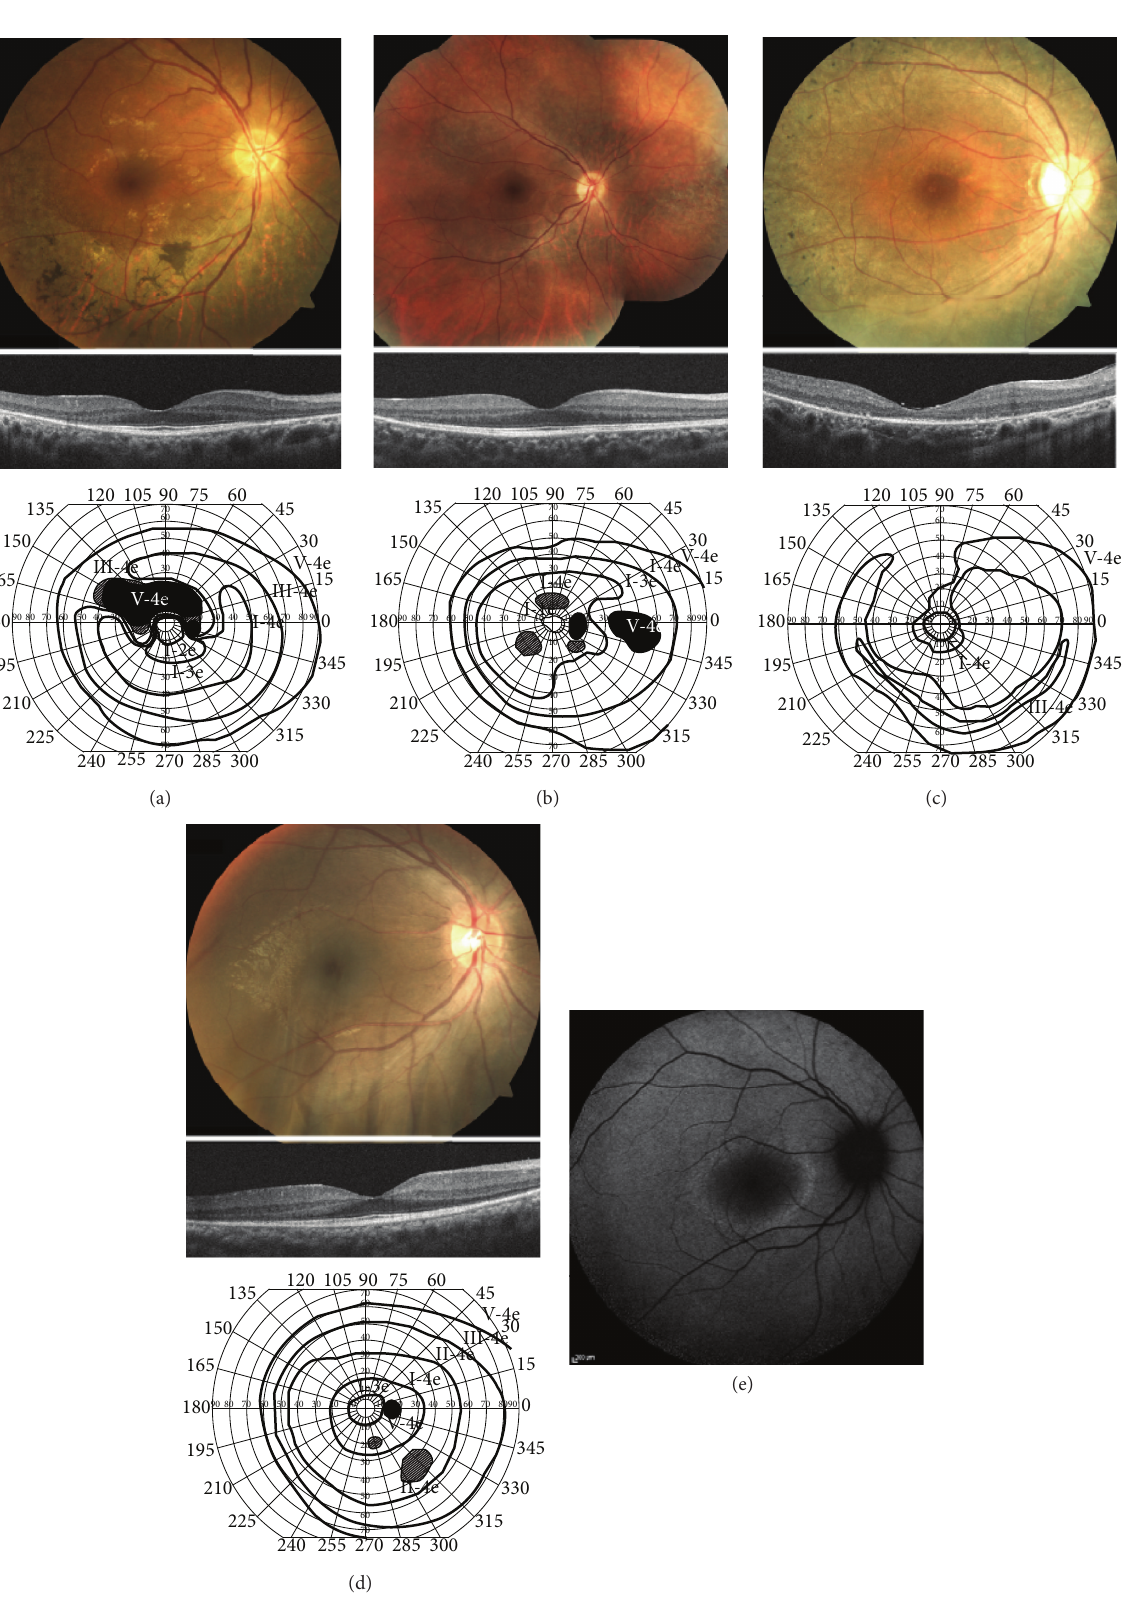
Figure 2: Fundus photographs, optical coherence tomography (OCT) images, and visual fields with Goldmann kinetic perimetry (GP) for the two Japanese families with retinitis pigmentosa. (a) Fundus photograph, OCT, and GP in the right eye of patient II-2 in family 1. (b) Fundus photograph, OCT, and GP in the right eye of patient III-1 in family 1. (c) Fundus photograph, OCT, and GP in the right eye of patient II-1 in family 2. (d) Fundus photograph, OCT, and GP in the right eye of patient III-1 in family 2. (e) A fundus autofluorescence image in the right eye of patient III-1 in family 2. See the Results section for